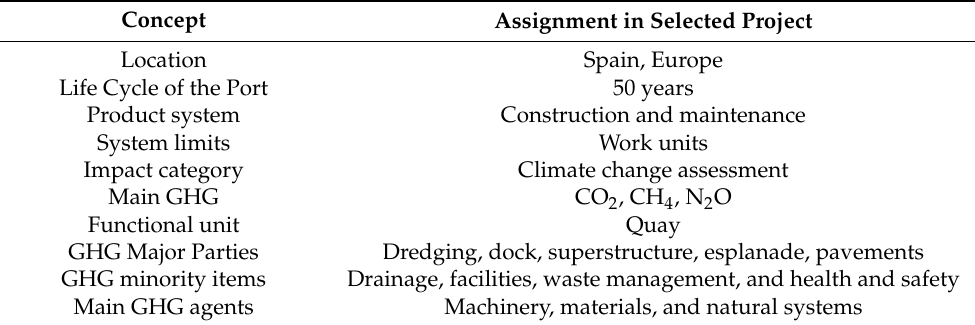
Table 2. Summary of Life Cycle Analysis (LCA) methodology variables in a port